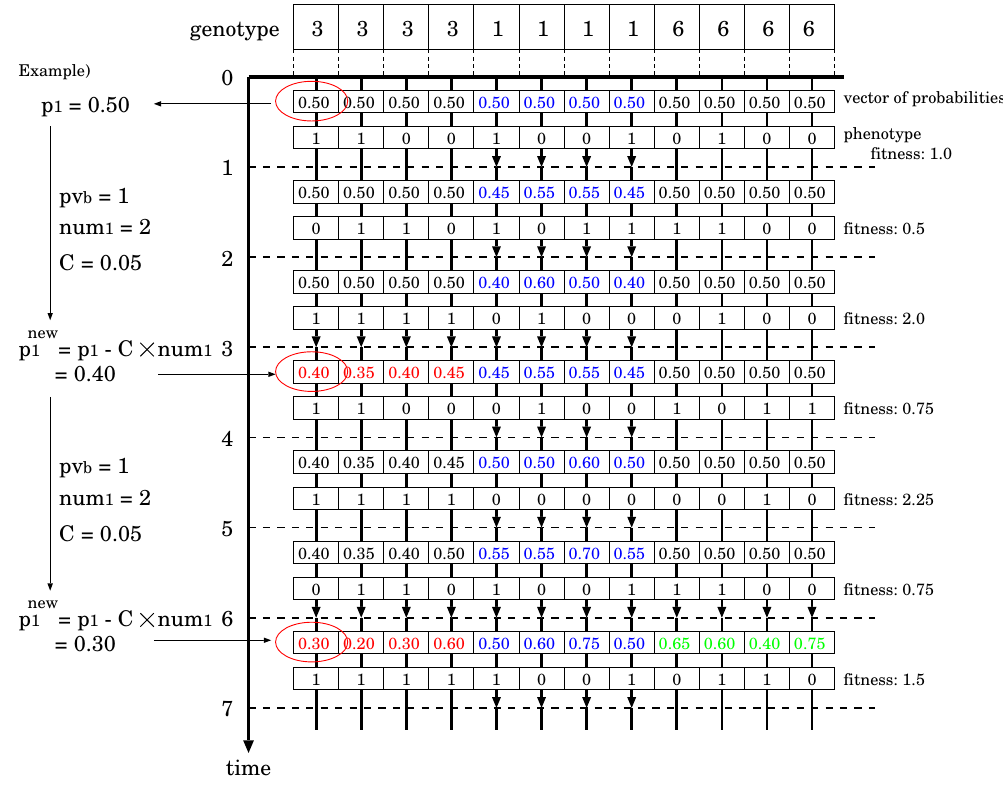
Figure 2. An example of the modification of the vector of